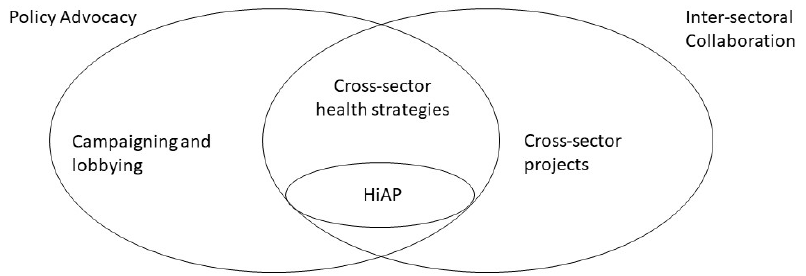
Figure 1. HiAP, policy advocacy and inter-sectoral collaboration (adapted from [35,36]).